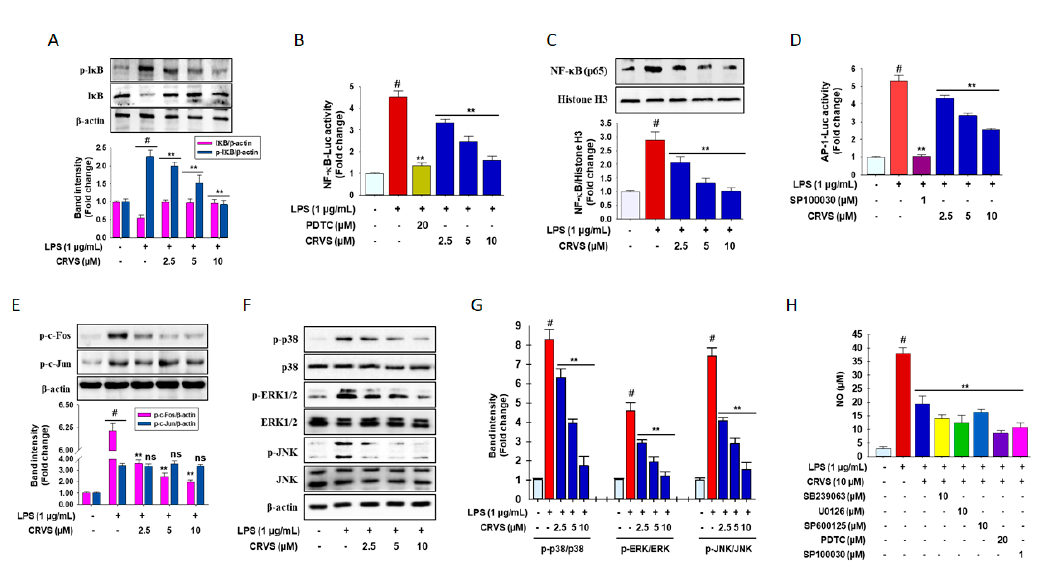
Figure 2. Inhibition of NF- κ B and AP-1 signaling through phosphorylation of MAPK by CRVS. Phosphorylation of inhibitor protein κ B (I κ B) ( A ); nuclear factor kappa-light-chain-enhancer of activated B cells (NF- κ B) promoter activity ( B ). Nuclear translocation of NF- κ B p65 subunit ( C ) is inhibited by CRVS in LPS-stimulated RAW 264.7 cells, analyzed by Western blotting. Activator protein-1 (AP-1) promoter activity ( D ); phosphorylation of c-Fos but not c-Jun ( E ) is suppressed by CRVS in LPS-stimulated RAW 264.7 cells. Cells (1 × 10 5 cells/mL) were seeded in a 6-well plate and incubated for 24 h. Then, the cells were treated with indicated concentrations of CRVS (2.5–20 μ M) or vehicle alone followed by LPS (1 μ g/mL) and incubated for 30 min. Effects of CRVS on mitogen activated protein kinases (MAPKs) (c-Jun N-terminal kinases (JNK), extracellular signal-regulated kinases (ERKs), and p38 mitogen-activated protein kinases (p38), phosphorylation in LPS-stimulated RAW 264.7 cells ( F ). Densitometric analysis of relative band intensities of proteins ( G ). NO production in the presence of various inhibitors (H). # p < 0.01 as compared with vehicle-treated control; ** p < 0.05 as compared with LPS alone.